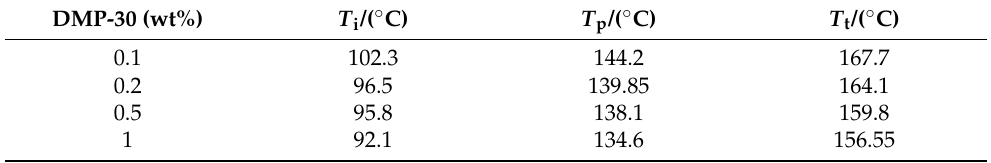
Table 1. Characteristic temperature of DEBGA/MHHPA system with different accelerator contents [41].